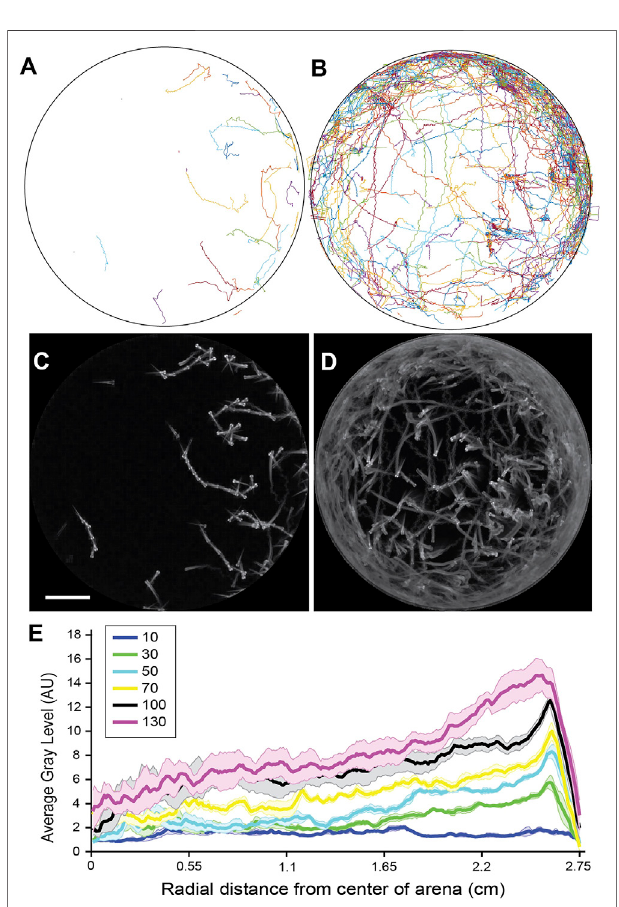
FIGURE 2 | Distribution of larval positions varies as a function of distancefromthearenawall.(A) Trackedtrajectoriesforasingletrialwith30 larvae. (B) Tracked trajectories for a single trial with 130 larvae. (C) Standard deviation z-projection for the frames corresponding to A. (D) Standard deviation z-projection for the frames corresponding to B. (E) Average gray area of standard deviation z-projections plotted from the center of the arena to the borderofthearenafor5trialsateachdensity.Themeanisshowninboldandthe standard error of the mean is shaded in a color corresponding to the density. Densities testedwere:10larvae, 30larvae, 50larvae, 70larvae, 100 larvae,and 130 larvae, in the same arena. Scale bar for A-D 1 cm.